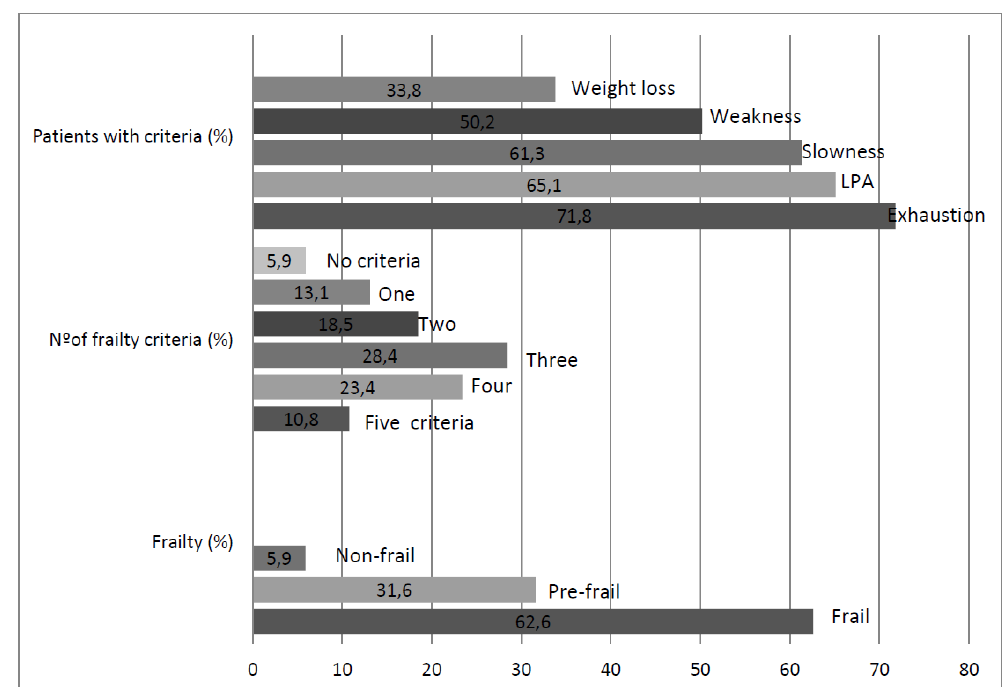
Figure 1. Prevalence of different aspects of frailty in a multicenter prospective cohort of polypathological patients. LPA: low physical activity.